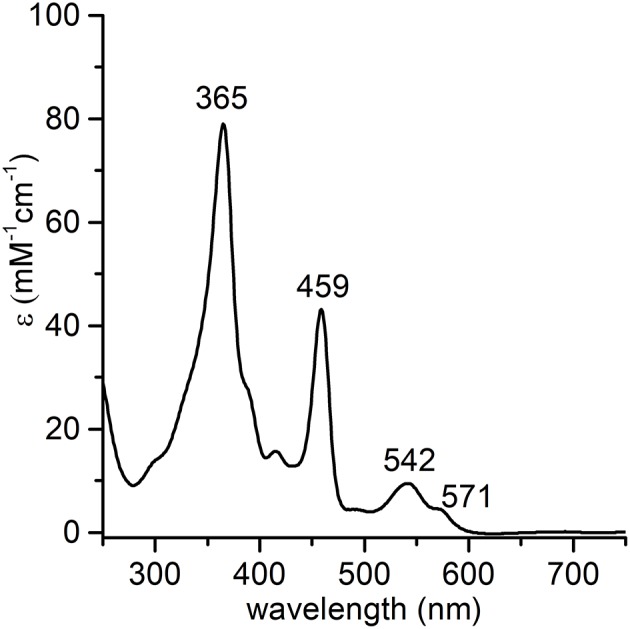
UV-vis absorption spectrum of MnIII-MC6*a (1.0·10−5 M) in acid aqueous solution (0.1 % TFA v/v, pH 1.8).